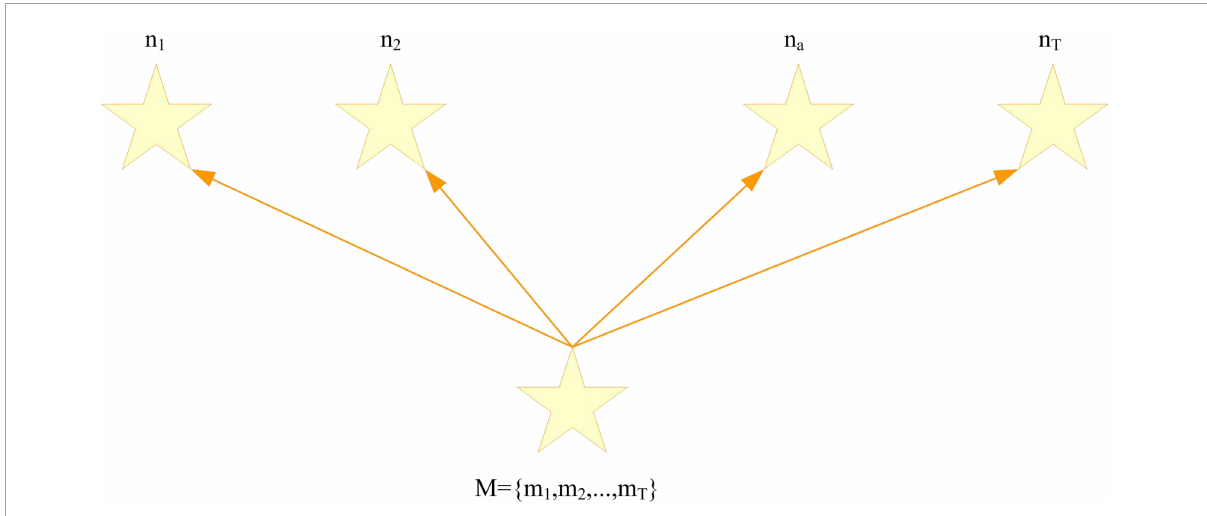
FIGURE1 Linear chain conditional random